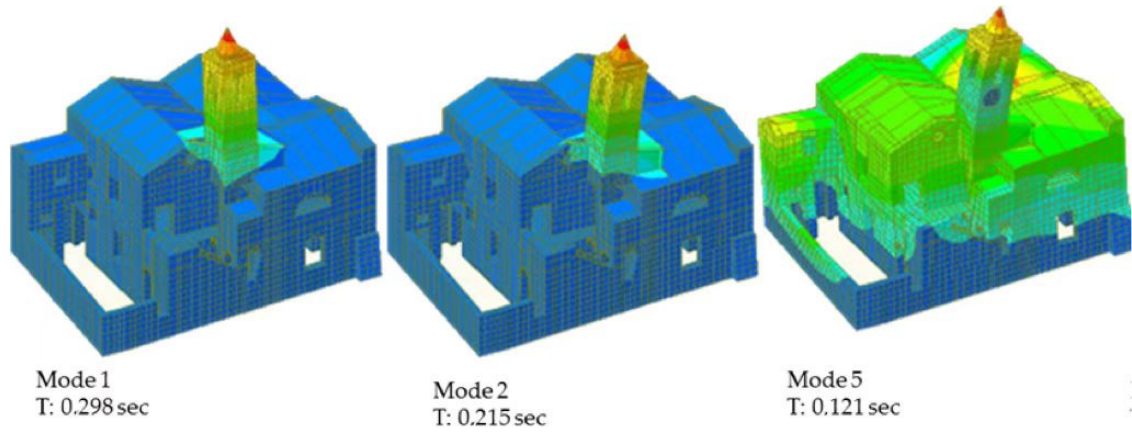
Figure 6. FEM Model.